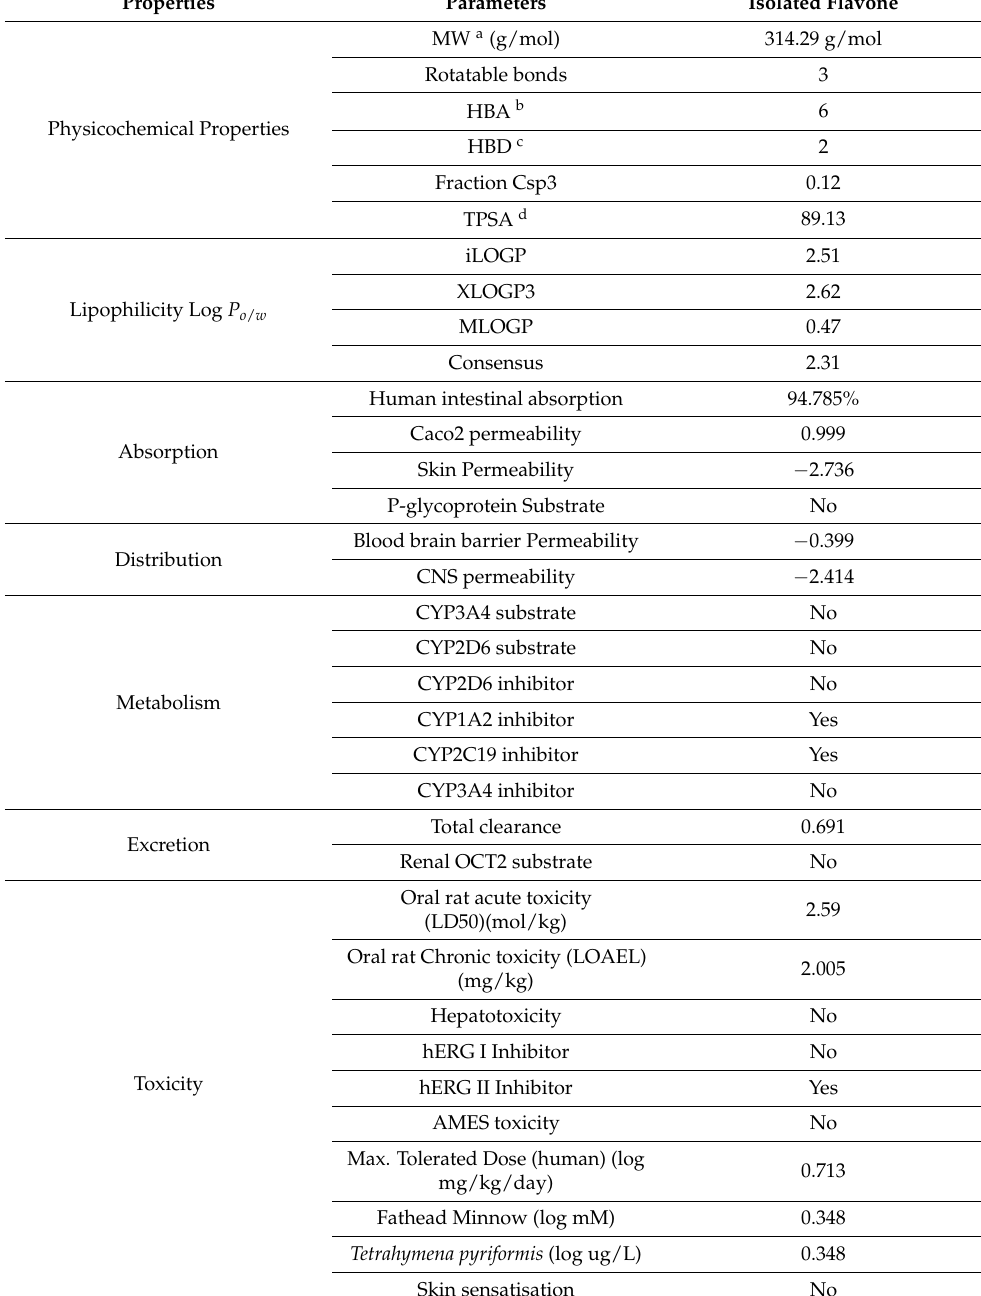
Table 4. Pharmacokinetic and ADMET values of isolated